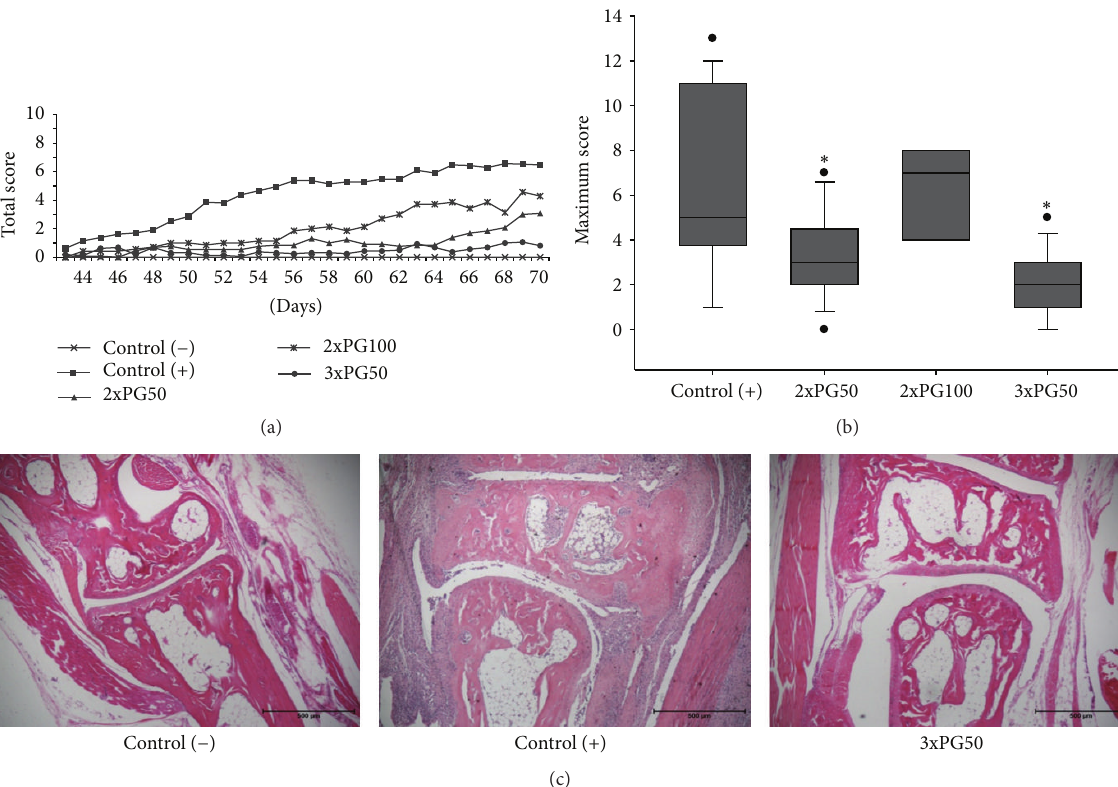
Figure 1: Effect of previous PG inoculation on experimental arthritis development. (a) Kinetics of total score, ranging from 0 to 16 for each animal, assessed by a visual scoring system based on the degree of edema and erytema. (b) Maximum score mean per group. (c) Histopathological analysis assessed 70 days after arthritis induction. Control ( − ): healthy group not previously injected with PG; control (+): arthritic group not previously injected with PG; 2xPG50, 2xPG100, and 3xPG50: arthritic groups previously injected with two (50 𝜇 g), two (100 𝜇 g), or three (50 𝜇 g) PG doses, respectively. Six to ten animals per group from one representative experiment of two performed. ∗ 𝑝 < 0.05